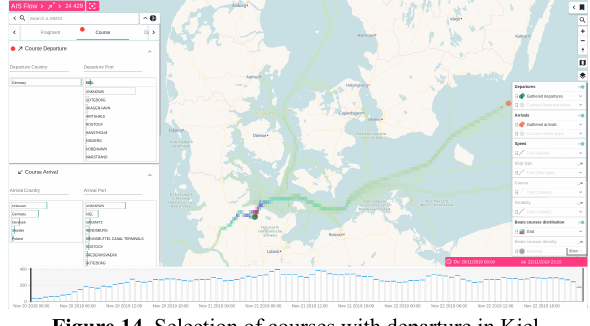
Figure 14 . Selection of courses with departure in Kiel